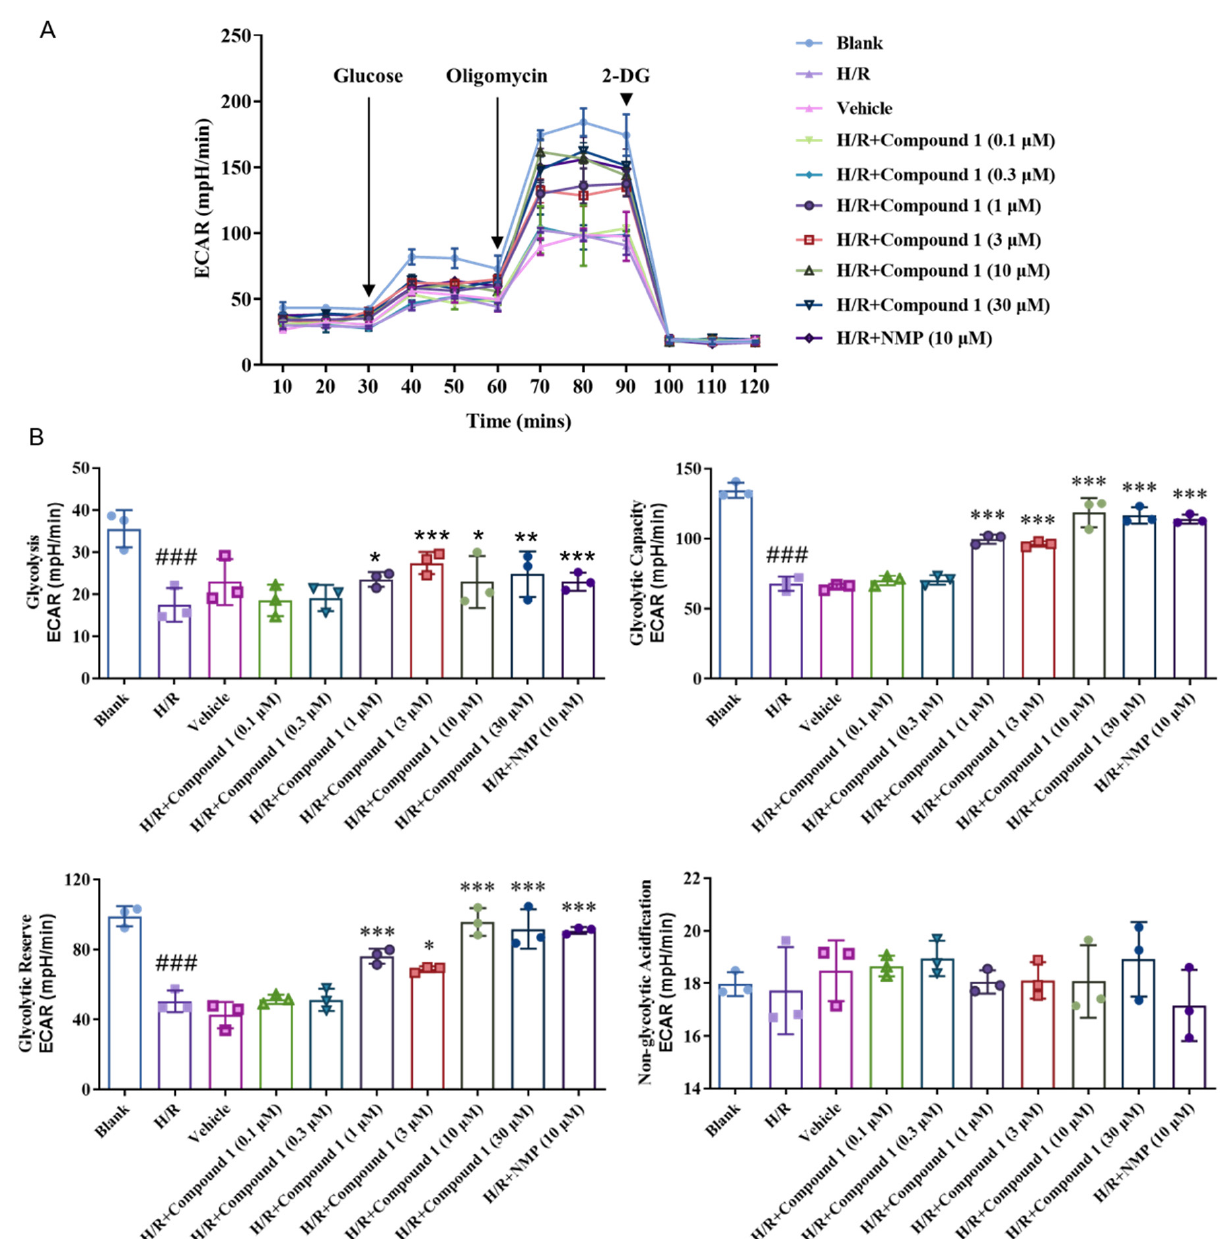
Figure 5. ( A ): Extracellular acidification rate (ECAR). ( B ): Bar graphs of Glycolysis, Glycolytic Capacity, Glycolytic Reserve, Non-glycolytic acidification. Data represent mean ± SD (* p < 0.05, ** p < 0.01, *** p < 0.001, vs. H/R Group; ### p < 0.001, vs. Blank Group).